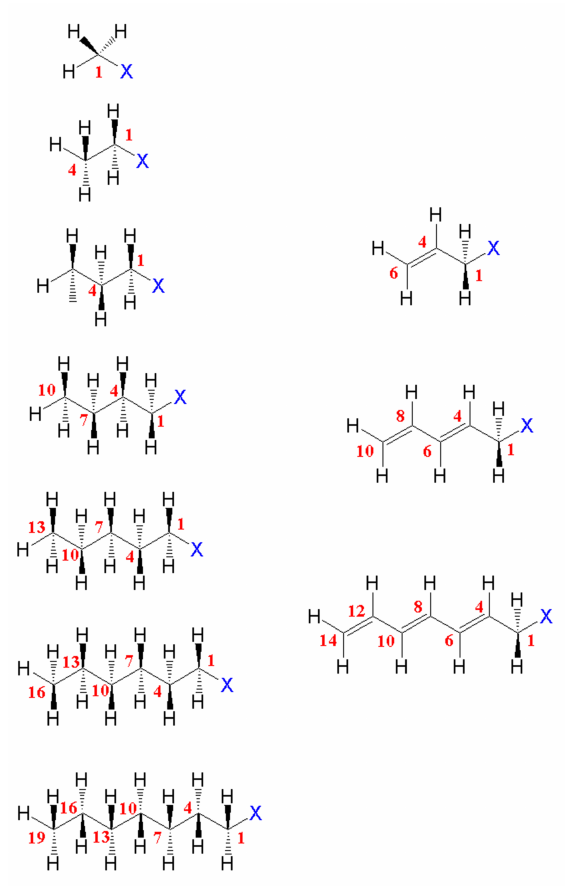
Figure 1. Studied molecules and numbering: halogeno-alkanes ( left ) and halogeno-alkenes ( right ).